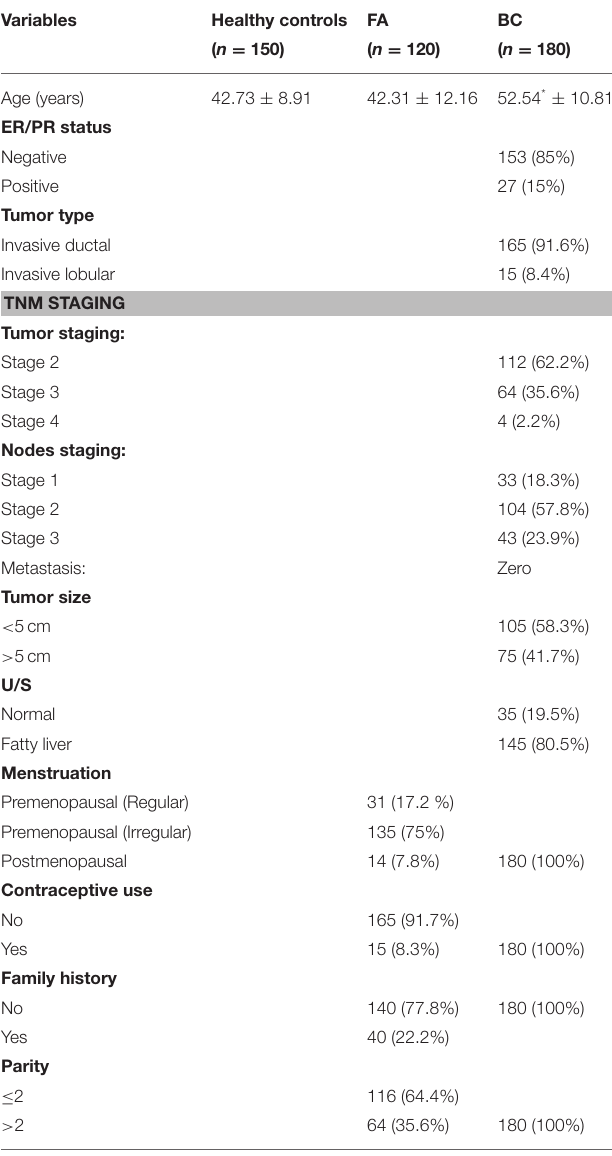
TABLE 1 | Pathological and clinical data of the studied groups. Variables